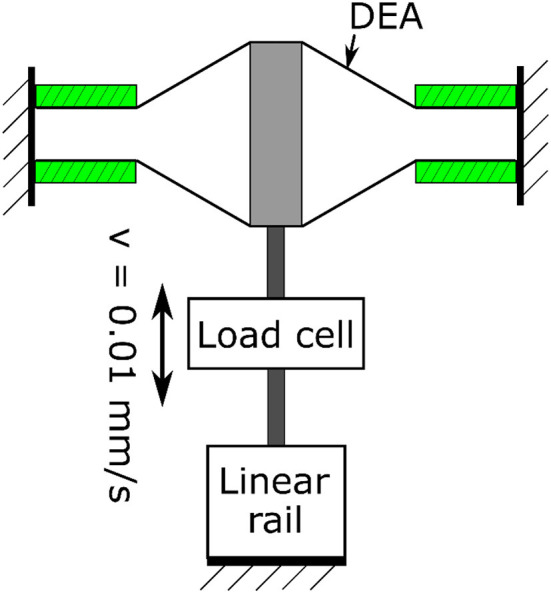
Double cone DEA passive quasi-static test setup.